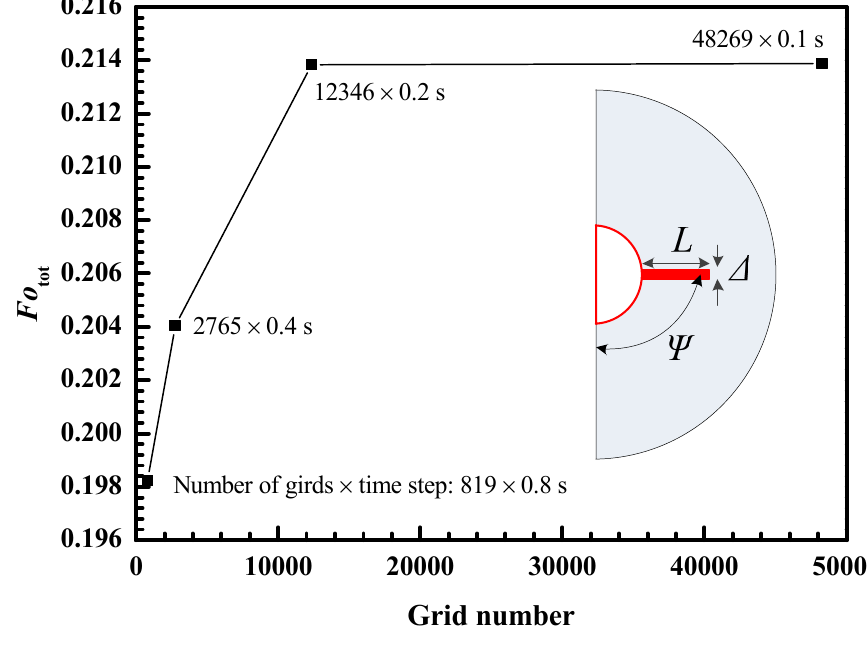
Figure 2. Variation of dimensionless total melting time with grid number.